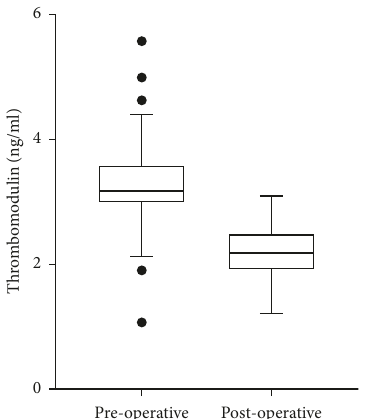
Figure 1: Boxplot graph of preoperative and postoperative thrombomodulin values.